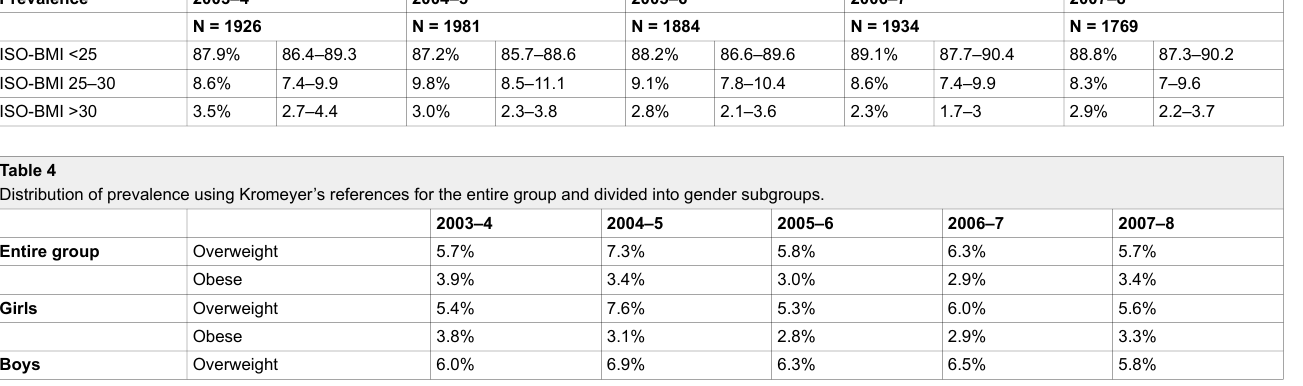
Table 3 Distribution of prevalence (95% confidence intervals) divided into ISO-BMI subgroups for boys. Prevalence